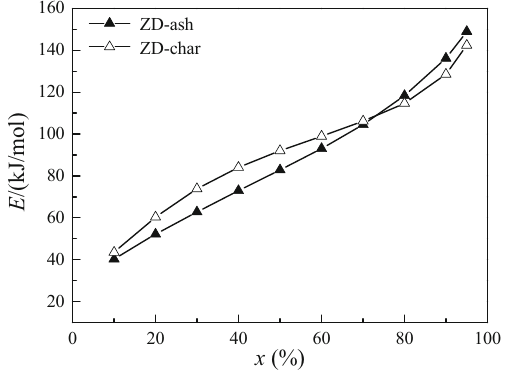
Fig. 8 Comparison of activation energy between ZD char and fly